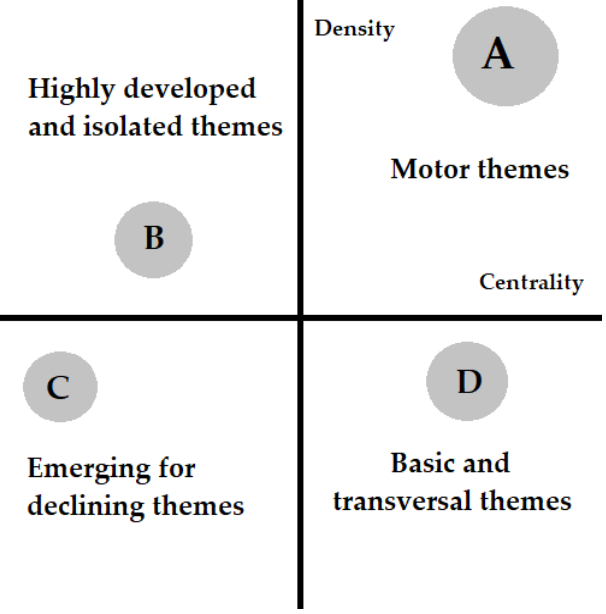
Figure 3. Strategy diagram.